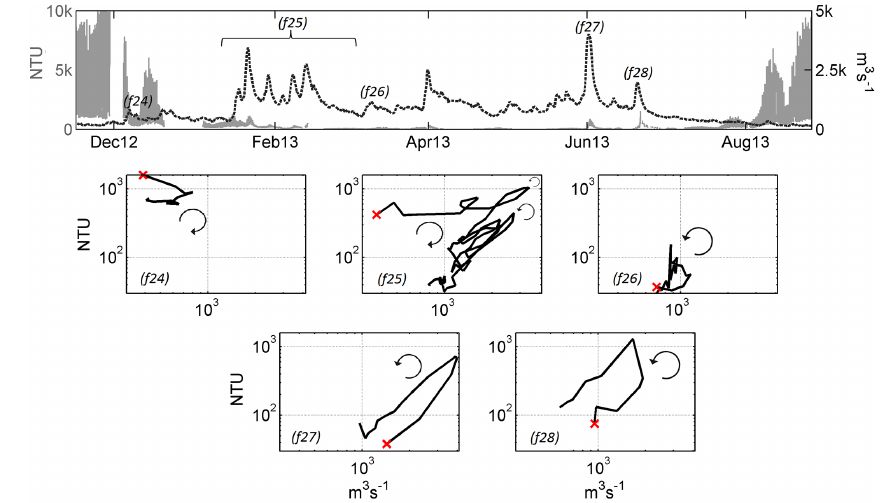
Figure 7. Relationship between Garonne discharge and turbidity at Bordeaux, and corresponding hysteresis patterns for the successive floods occurring since the downstream flushing, in December 2012, and the following upstream migration, in August 2013, of the TMZ; f plus a number refers to the flood events according to Fig. 3 and Table 1.